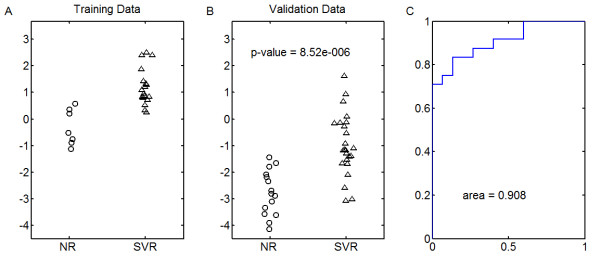
Verification of predictor. Predictive accuracy of the SRM assay for predicting response to therapy in Hepatitis C. Training was on the initial 25 samples, and validation was on the followup 38. Panel a shows behavior of the model on the trained samples and panel b shows behavior on the hold-out samples. The ROC curve in panel c shows accuracy only on the hold-out samples.